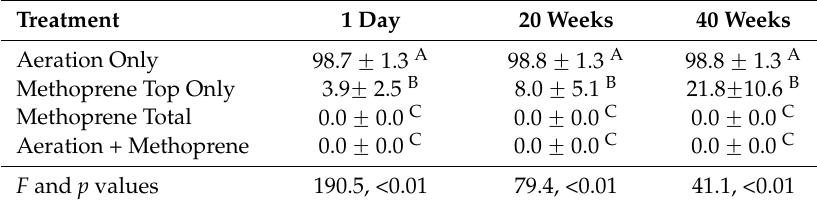
Table 8. Mean percentage ( ˘ SE) of P. interpunctella adults emerging (from addition of 20 eggs per jar) from 40 g-samples of wheat taken from bins at one day after treatment, 20 weeks and 40 weeks post-treatment. Means within a column with same letter, for which there was a significant ( p < 0.05) F-statistic, are not significantly different (LSD test, p < 0.05, SAS Institute, degrees of freedom for analysis within date for treatment were 3,